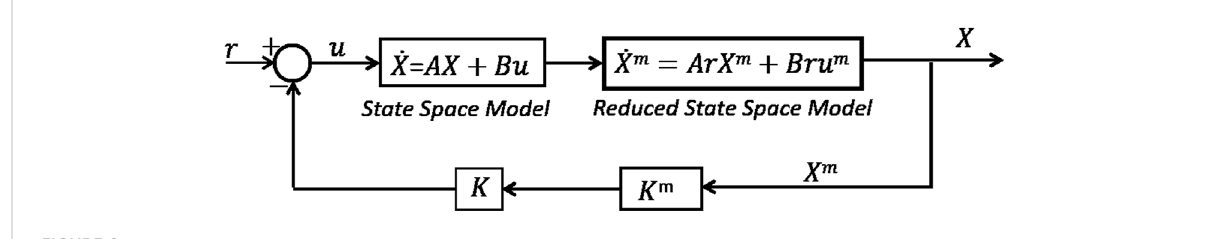
The LQR control design diagram in the reduced model.